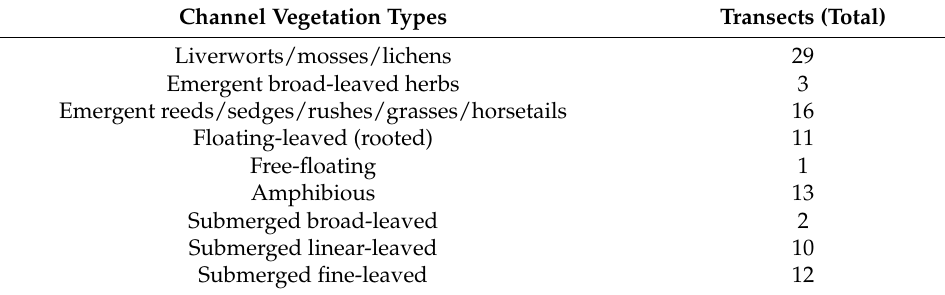
Table 5. Representativeness of observations in Section